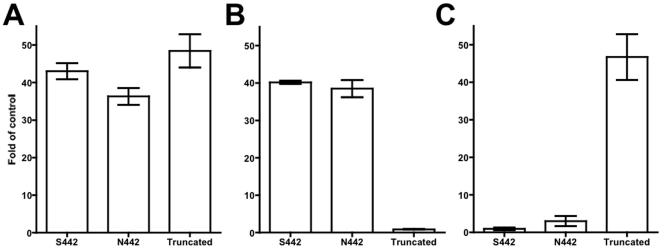
Overexpression of α9 nAChR variants in BEP2D cells.The relative amounts of mRNA encoding the variants of α9 nAChR overexpressed in BEP2D cell lines were measured by qPCR, as detailed in Methods, using the primers common for all α9 isoforms (A), specific for the full length α9 (B), and specific for the 122 aa truncated α9 variant (C). Data are means ± SEM of qPCR experiments performed with at least 3 biological replicates of each cell line and expressed as fold of pLVX control, taken as 1. One-way ANOVA with the Bonferroni post-test was used for analysis of allele-specific qPCR data.